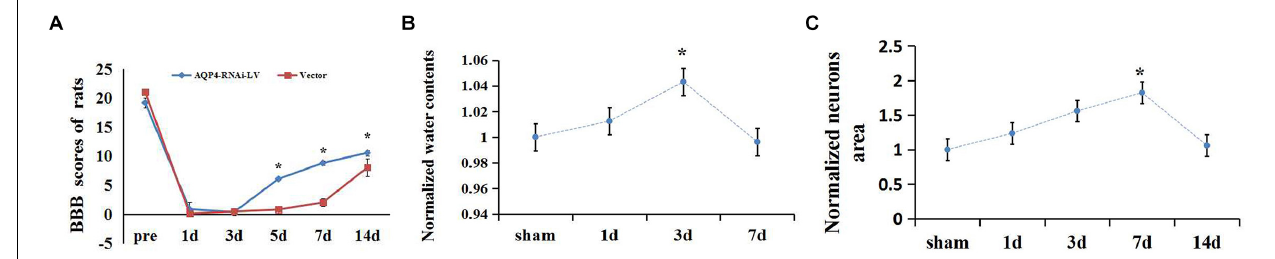
FIGURE 1 | Extent of edema in spinal cord and changes of BBB scores after SCC. (A) The scores at 7, 14, and 28 days increased significantly compared to 3 days ( n = 6, P < 0.05) in the SCC group. (B) Date presented as fold changes normalized to sham. The spinal cord tissue water content is recorded (70.17 ± 0.38)% in the sham group. At 1 day post-SCC, the percentage of water content increased to (71.04 ± 0.41)% ( n = 6, P > 0.05) within the injury epicenter. A further increase was recorded at 3 days (73.19 ± 0.3)%, while on day 7 (69.90 ± 0.44)% ( n = 6, P < 0.05) a decline appeared, compared with day 3. ∗ denotes P < 0.05, compared with the sham group. (C) Date presented as fold changes normalized to sham. The area of motor neurons clearly increased in the anterior horn of the spinal cord at 3, 7, and 14 days after SCC, which showed the degree of cytotoxic edema. ∗ P < 0.05 when compare to sham group ( n =